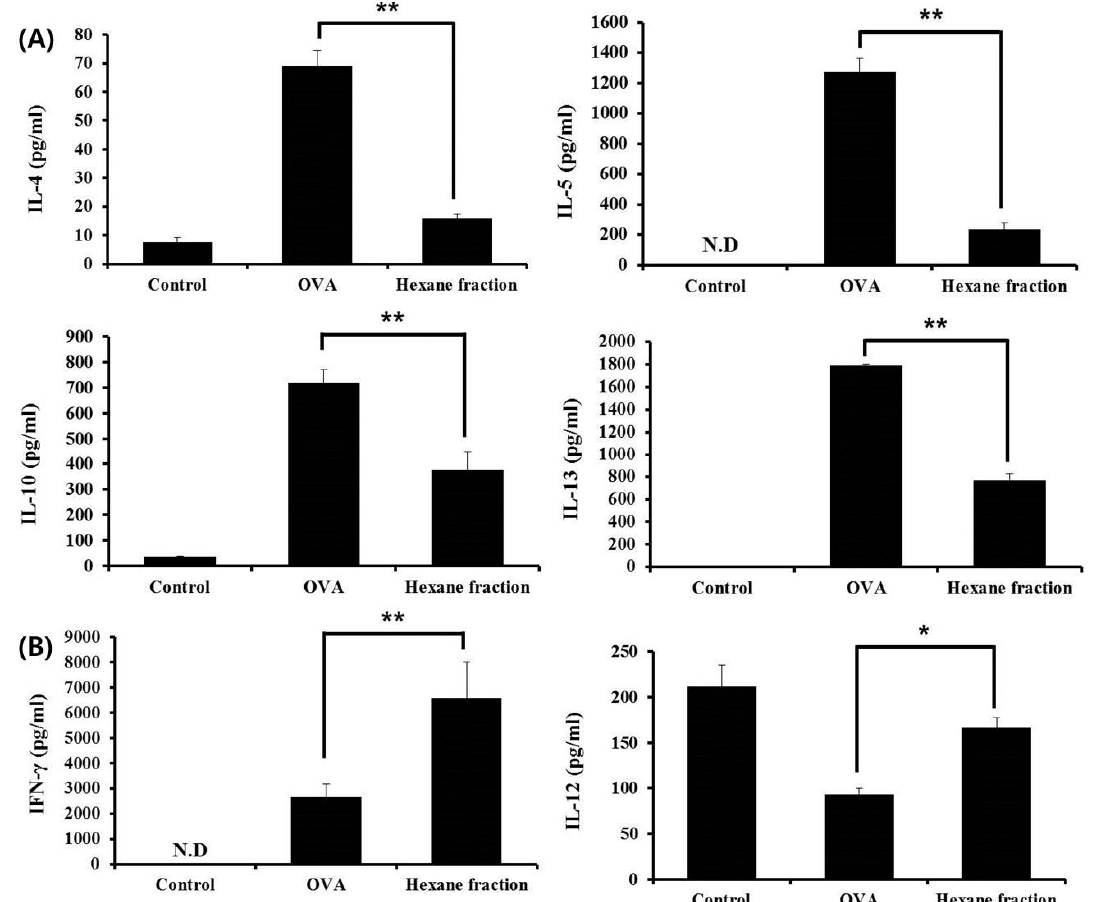
Figure 3. Effects of skullcap hexane fraction (50 μ g/L on OVA ‐ induced Th2 immune response ex vivo. ( A ) Th2 ‐ associated cytokines such as IL ‐ 4, IL ‐ 5, IL ‐ 10 and IL ‐ 13; ( B ) Th1 ‐ associated cytokines, such as IFN ‐γ and IL ‐ 12, were quantified by enzyme ‐ linked immunosorbent assay (ELISA)